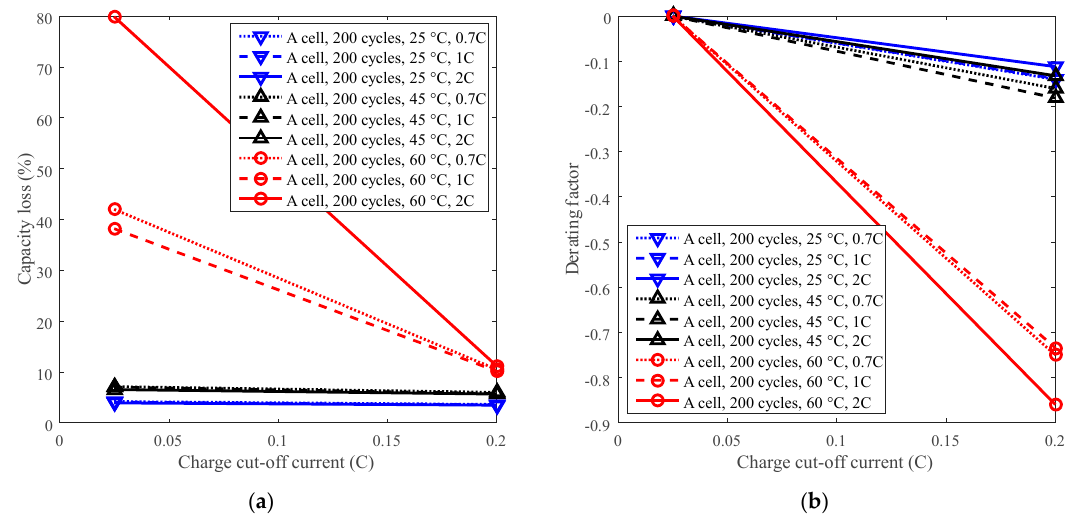
Figure 11. Derating of charge cut-off current. (a) Capacity loss vs. charge cut-off current. (b) Derating factor vs. charge cut-off current.